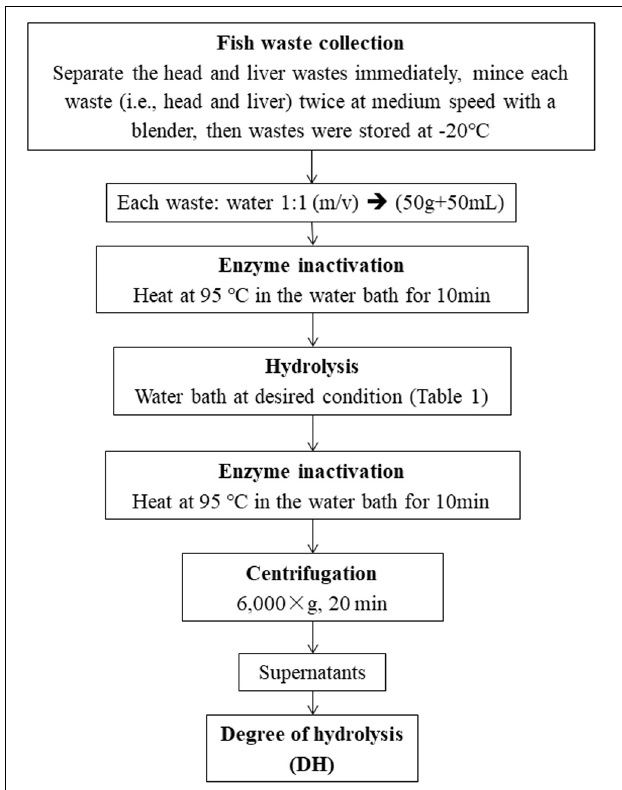
FIGURE 1 | Flow chart of the enzyme hydrolysis